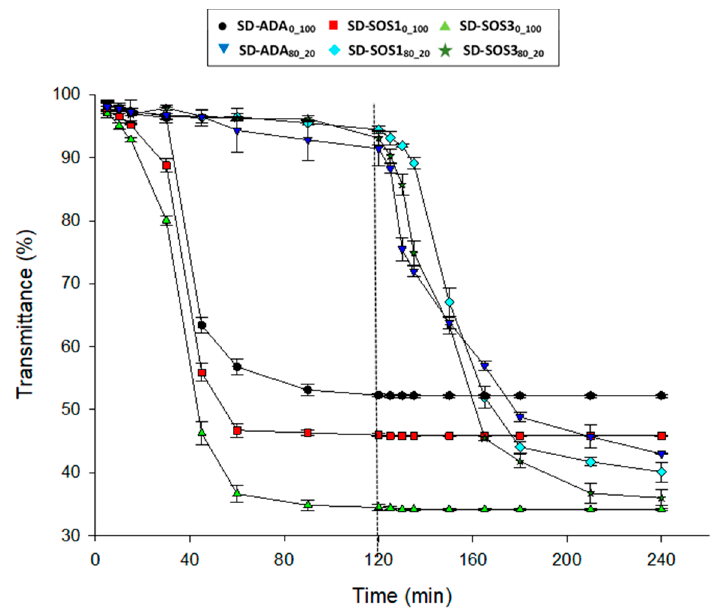
Figure 10. Transmittance of reconstitution medium vs. time for the spray-dried products (dotted line denotes pH change of the dissolution medium from 1.2 to 6.8).